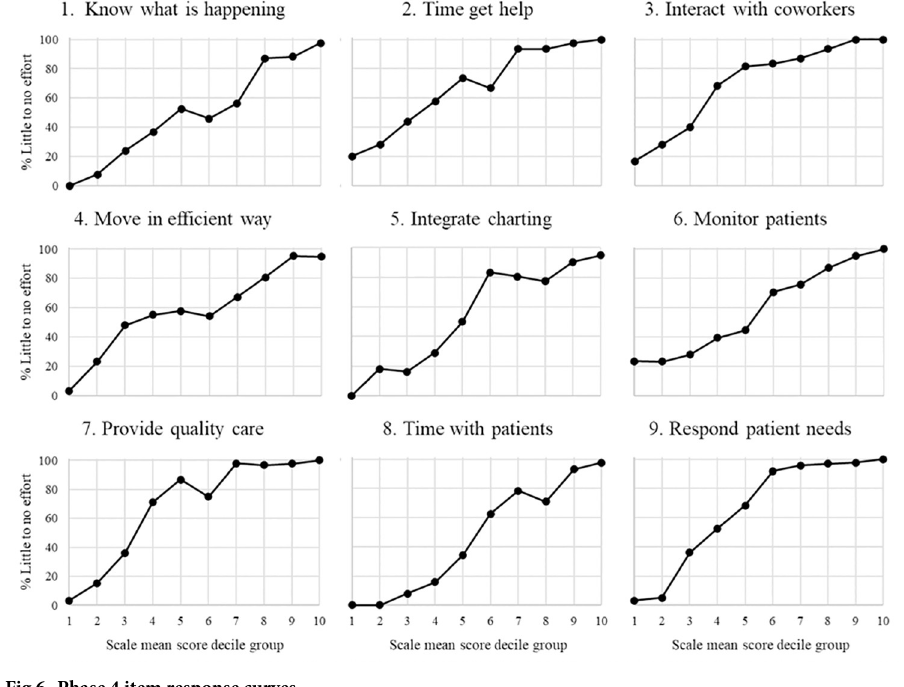
Fig 6. Phase 4 item response